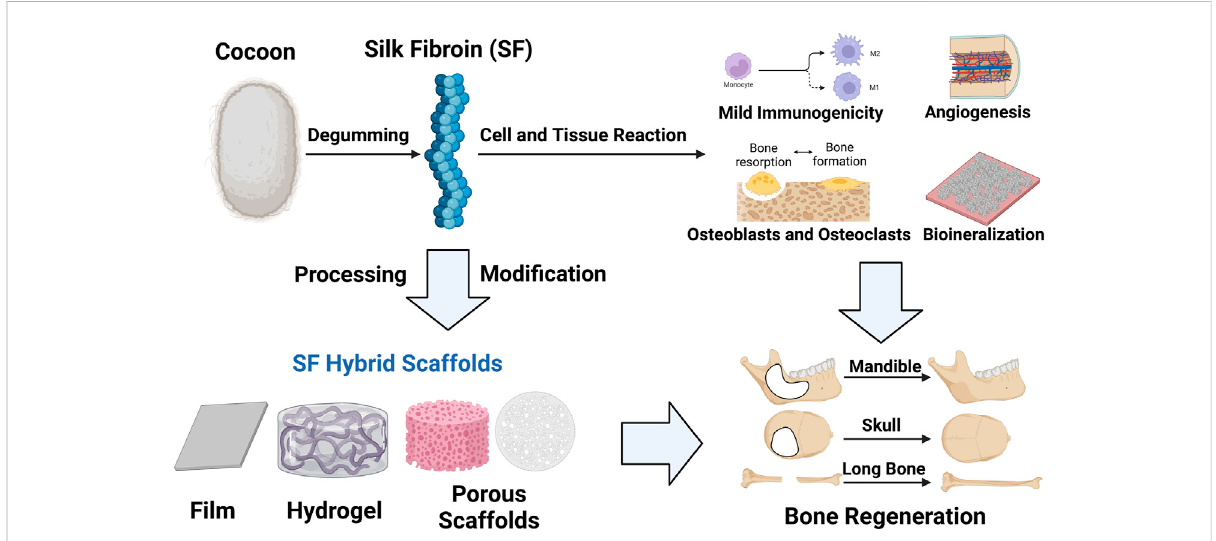
FIGURE 2 Graphical diagram for fabricationof SFscaffoldsand their cell and tissue responses,whichmakes contributions to bone regeneration.(Created with